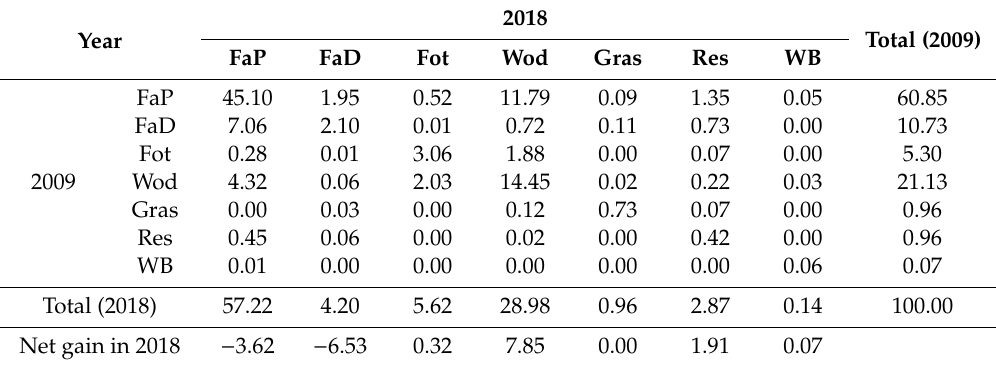
Table 4. Percentages of conversion of each LULC during 2009–2018 (% of total